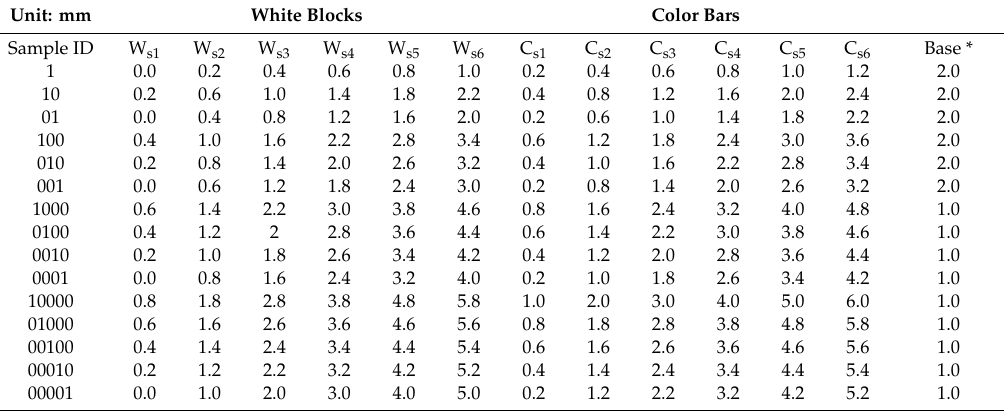
Table 2. The printing thickness for each stair in all 3D color test